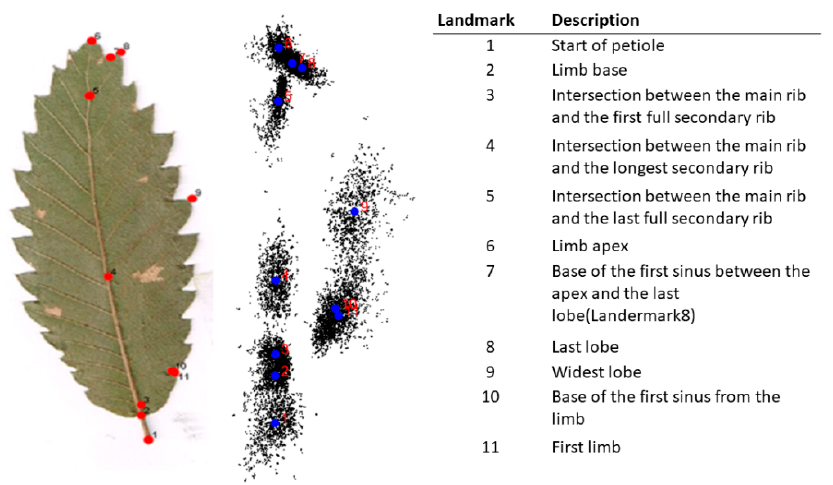
Figure 2. Position and description of landmarks on the right side of a leaf in the Akfadou forest and generalized procrustean overlay of all samples. Average conformations (consensus) are represented by blue dots.